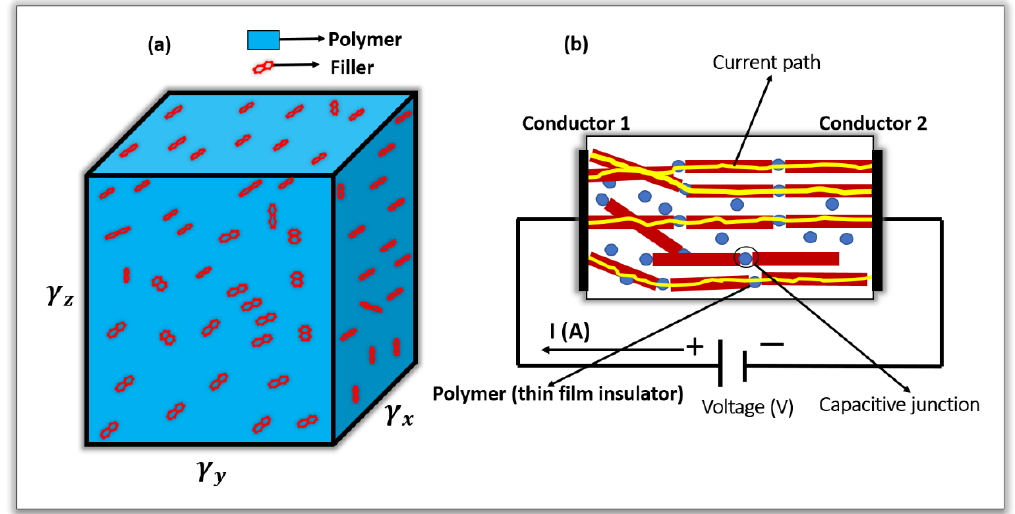
Figure 2. ( a ) RVE for the graphene–PPy nanocomposite and ( b ) resistive network of the randomly dispersed graphene in polypyrrole. The current path is formed when the bias voltage is larger than the tunneling barrier potential.